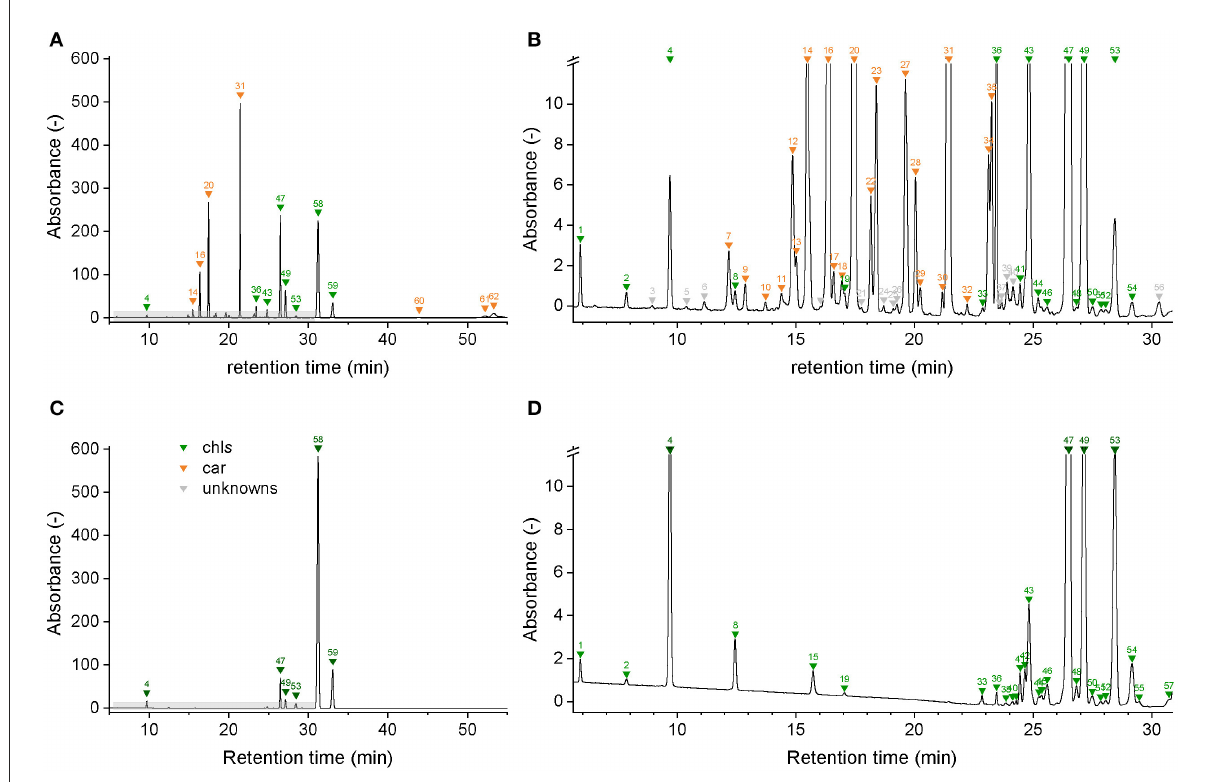
FIGURE3 Chromatograms of a spinach sample at 450nm (A,B) and at 665nm (C,D) . Individual compounds are listed in Table